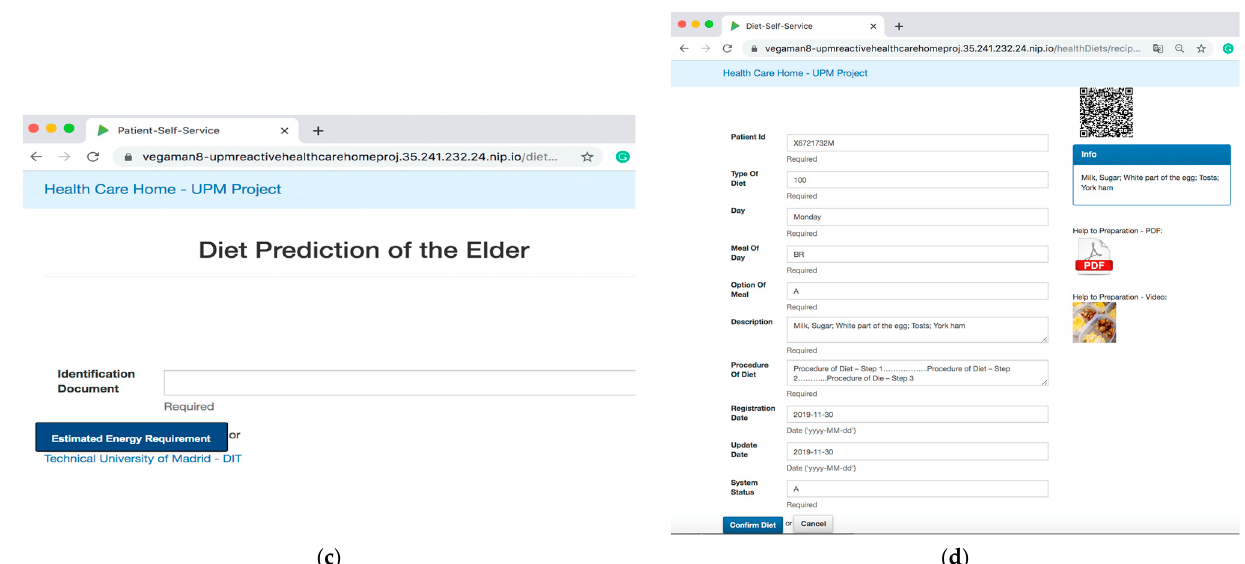
Figure 5. ( a ) Diet prediction, prescription, and monitoring process. ( b ) Graphical user interface to collect the personal physical data of the elderly person. ( c ) Graphical user interface for calculating the EER. ( d ) Graphical user interface that helps to prepare meals.